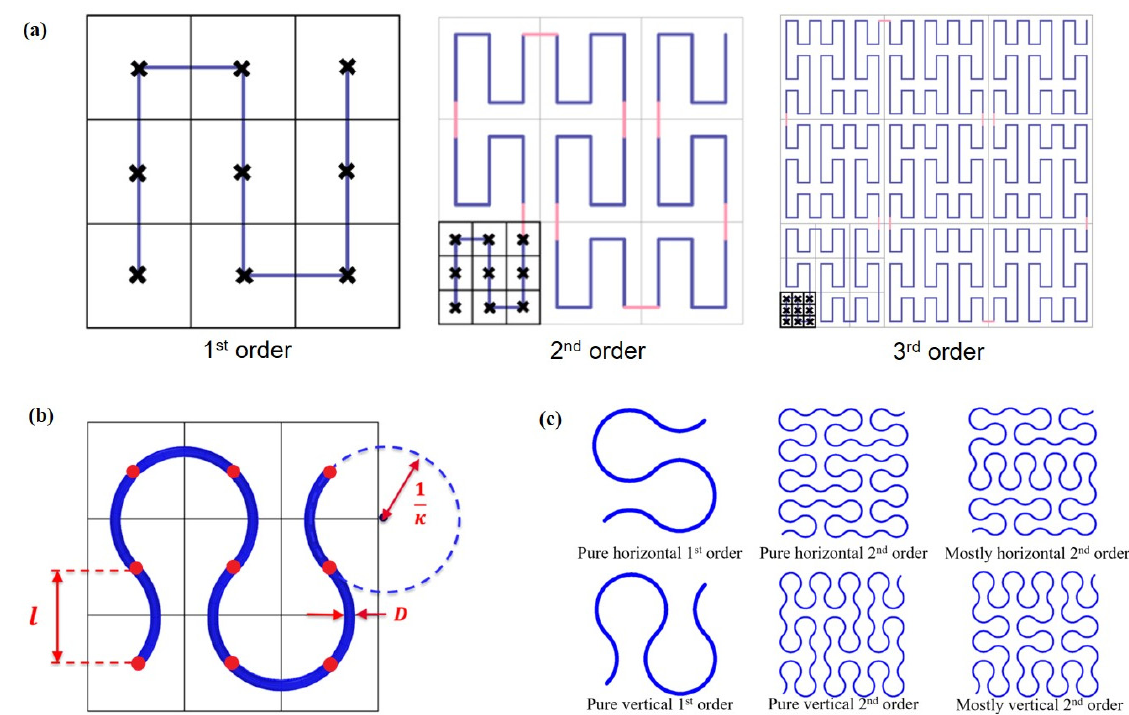
Figure 2. ( a ) Construction of the first three orders of Peano curves; ( b ) schematic design of a smoothed Peano curve, including control points (red dots), the side length of a small square ( l ), arc curvature ( k ), and diameter ( D ); ( c ) variants of Peano curves at different orders to be investigated in this study.